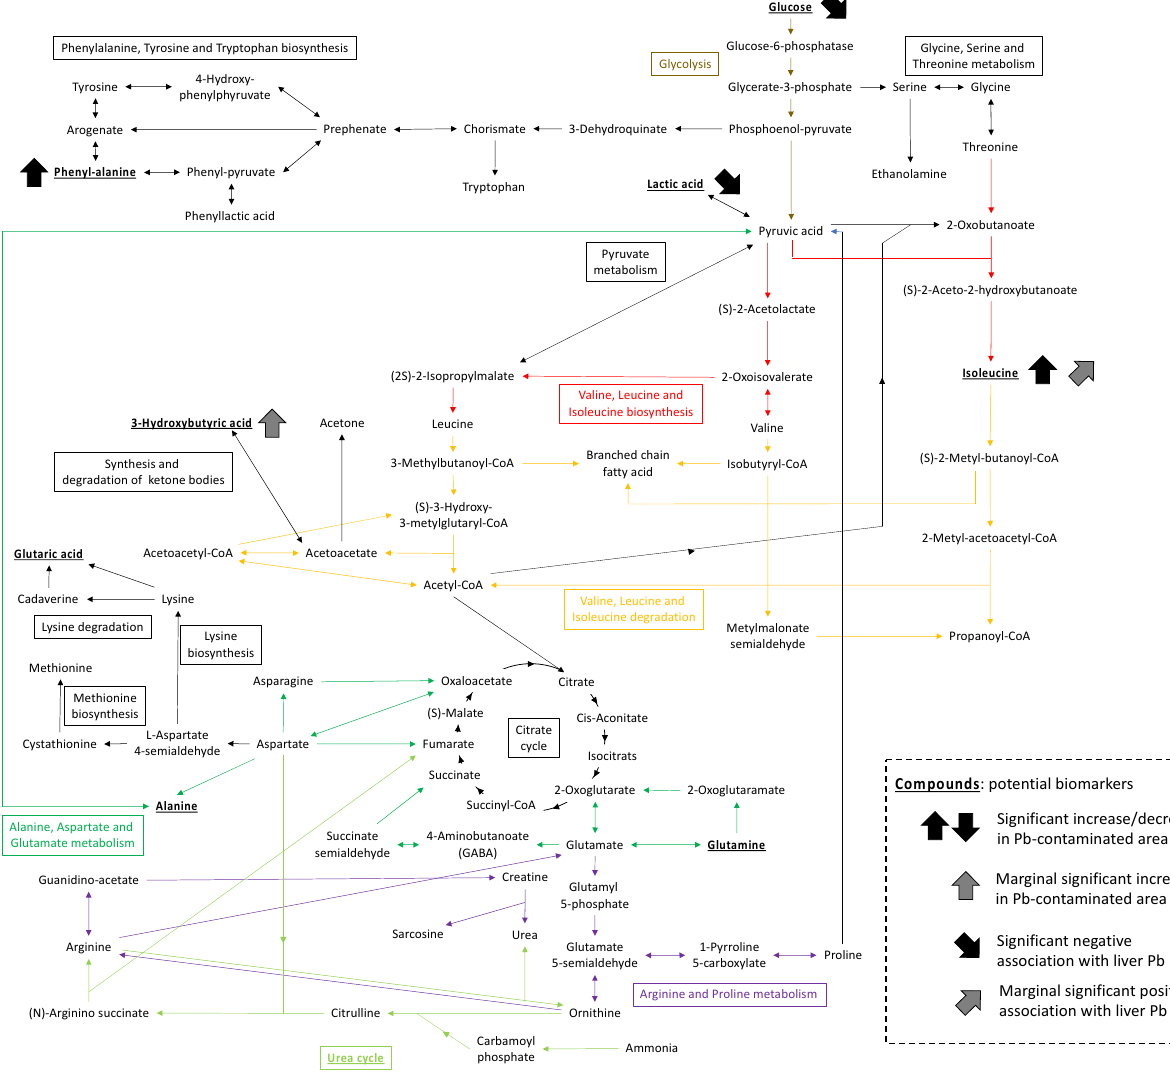
Figure 5. Suggested biomarkers (bold and underline) and metabolic pathways identified in rodents in this study.